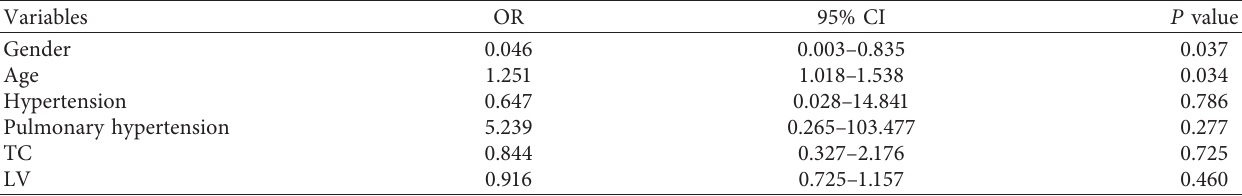
Table 5: Multivariate logistic regression analyses of multiple variables and the LAMRT originating from the